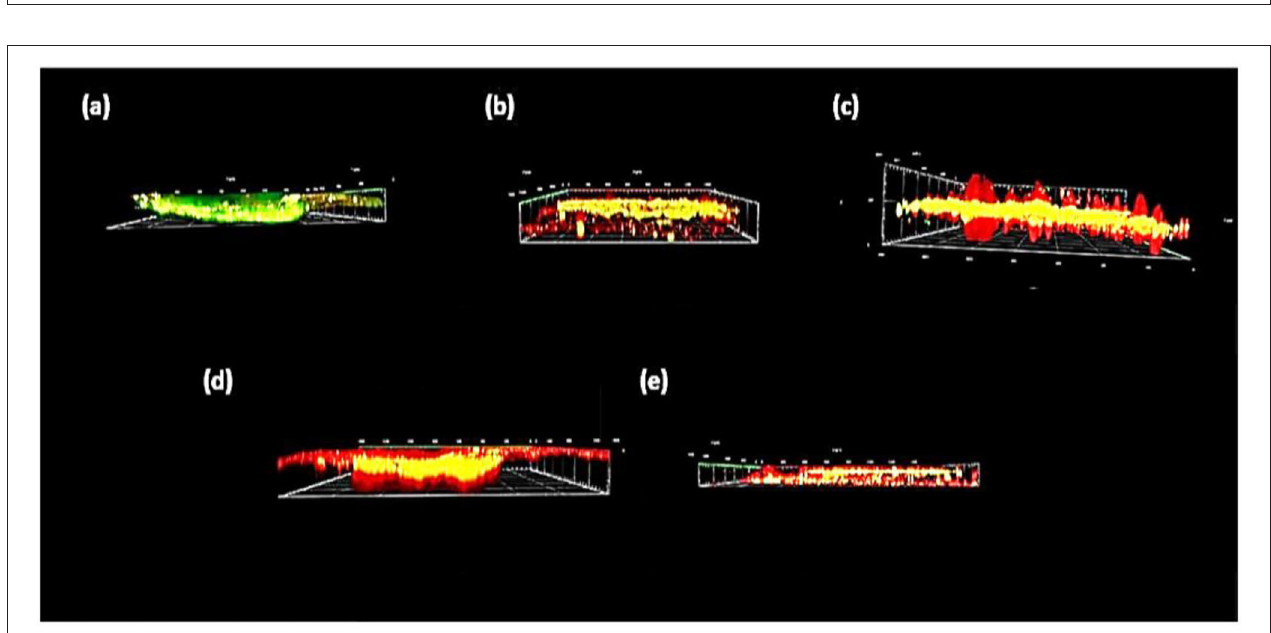
FIGURE 7 | Mean values of bacterial adhesion in all tested group.